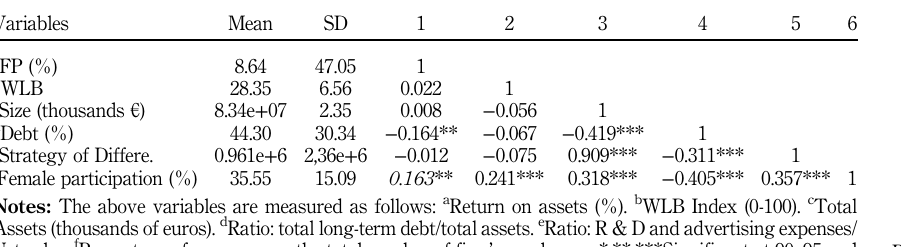
Pearson correlations